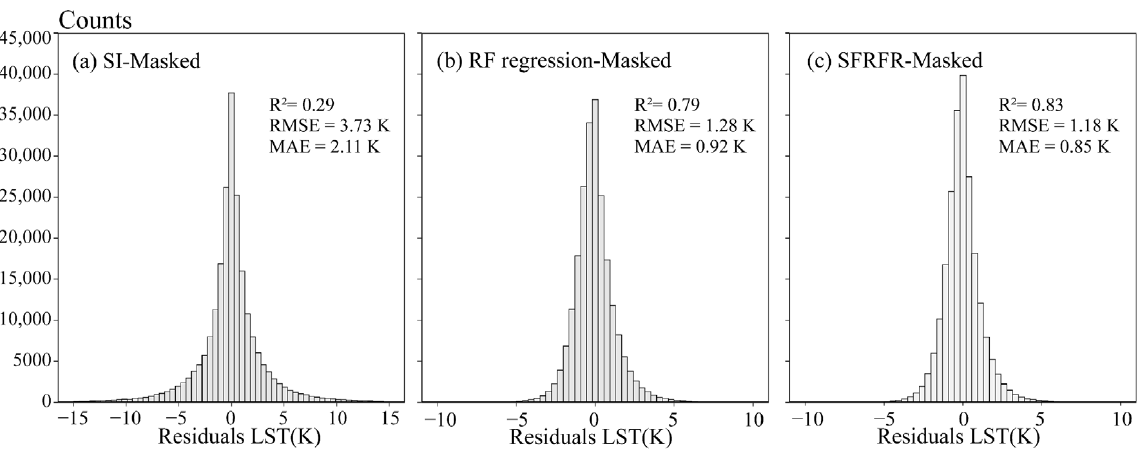
Figure 8. Distributions of residuals between the estimated and masked LST: ( a ) masked LST against SI LST, ( b ) masked LST against RF regression LST, and ( c ) masked LST against SFRFR LST. Table 3. Errors between the results of the three models and the original LST.